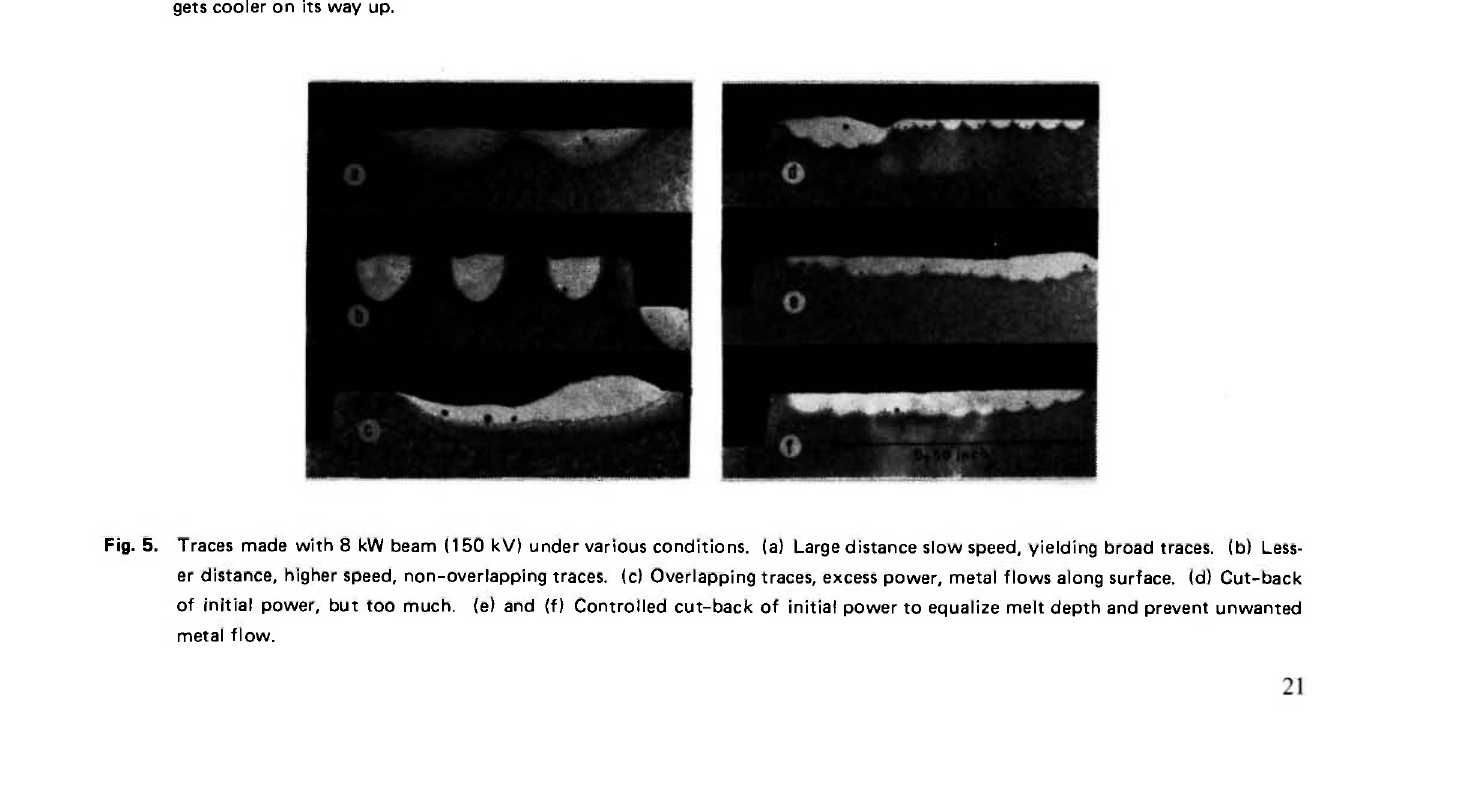
Fig. 3. (left): Electron beam of 9 kW impinging on a rotating rod of cast iron, making a melt trace. The movement is away from the viewer at the top and toward the viewer at the bottom. One sees how the melt trace gets cooler on its way up.